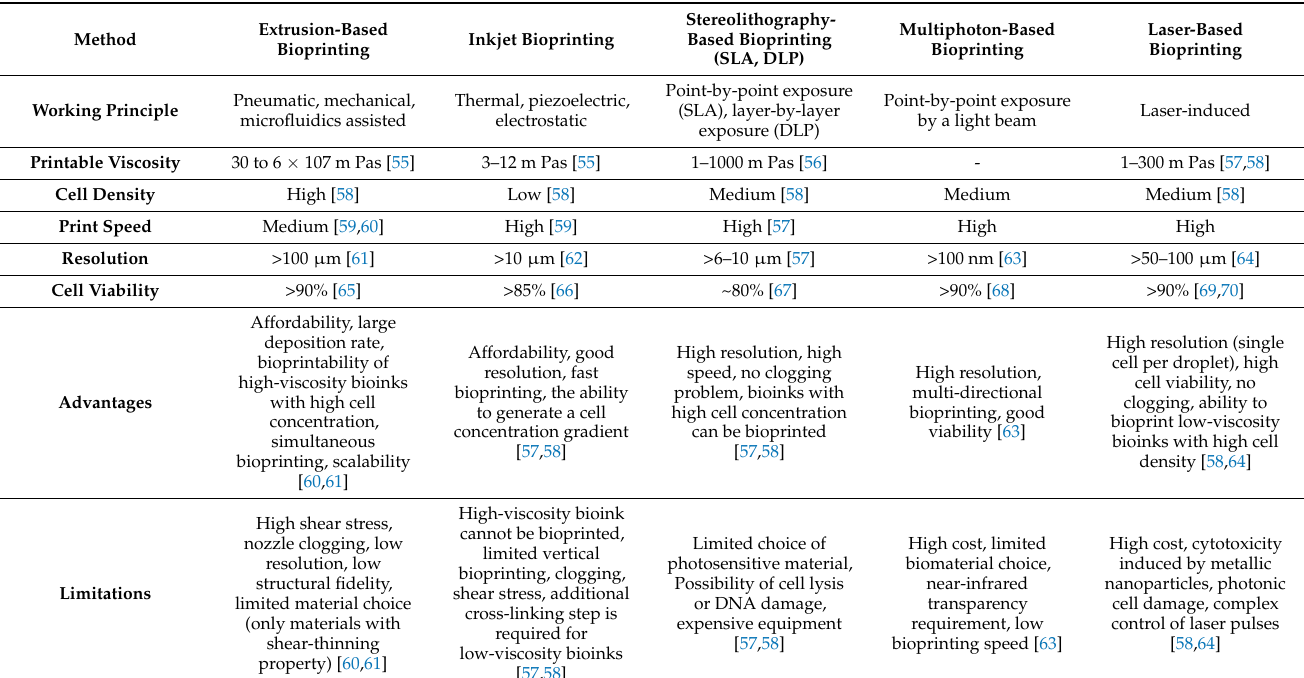
Table 1. Summary of properties of commonly used 3D bioprinting methods for OOC applications. Reproduced with permission from [54], 2022, the authors, under the terms of the Creative Commons CC BY